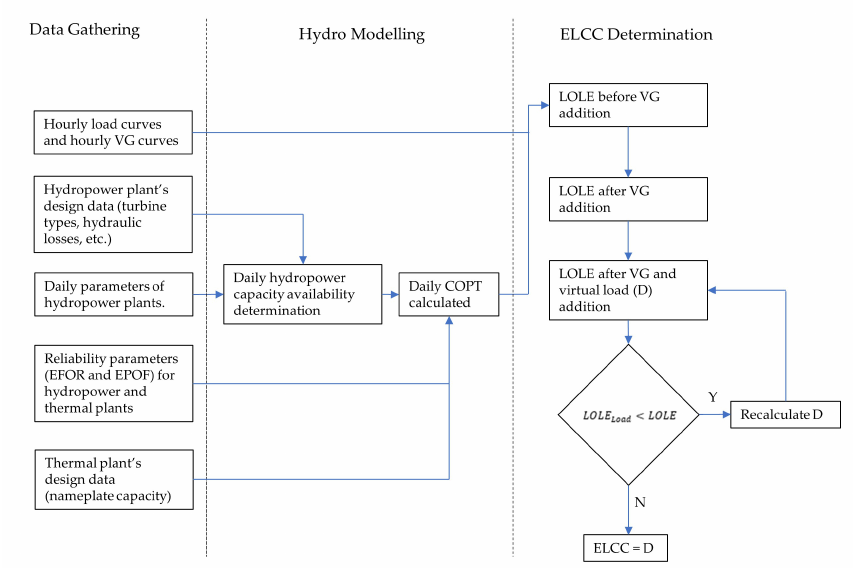
Figure 1. A general flowchart of the employed method to determine ELCC in systems with variable dispatchable